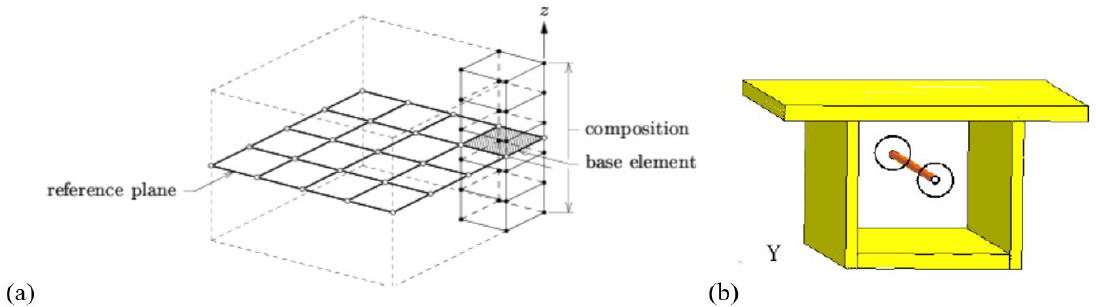
Figure 2. Composition of results from solid elements: (a) in a quadrangular reference plane or (b) in a reference line